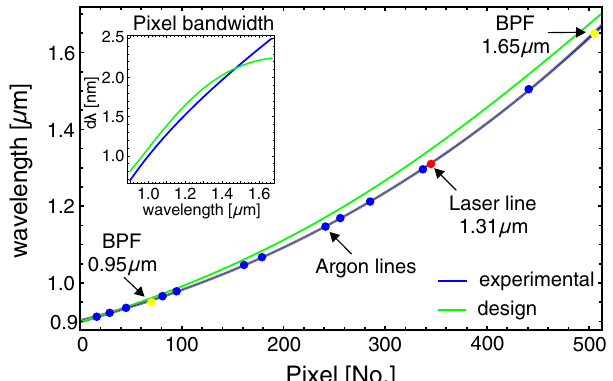
FIG. 11. Wavelength calibration of the InGaAs detector: Several Ar lines are identified (marked in blue) on the InGaAs array detector. The marks for the BPF ’ s and the alignment laser fall well in line. The blue solid line represents a third order polynomial fit. The 3 σ standard deviation of the fit model is found to be on average